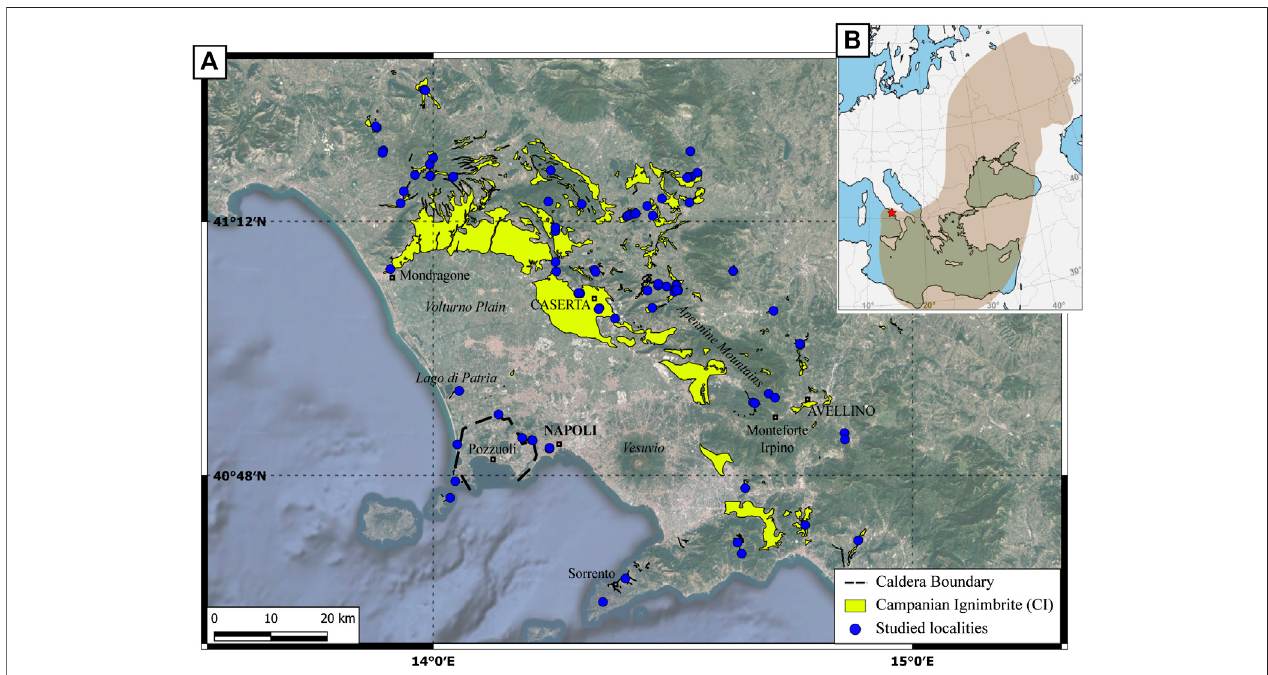
FIGURE1| The Campanian Ignimbrite distribution (A) .The Campanian Ignimbrite (CI) distribution intheCampanian region (thebasemap isfromGoogleSatellite), de fi nedmerging fi eldworkand geological maps(ServizioGeologicod ’ Italia,1963;ServizioGeologicod ’ Italia,1966;ServizioGeologicod ’ Italia,1967;Servizio Geologico d ’ Italia, 1971a; Servizio Geologico d ’ Italia, 1971b; Servizio Geologico d ’ Italia, 1975; ISPRA, 2009; ISPRA, 2010; ISPRA, 2011a; ISPRA, 2011b; ISPRA, 2011c; ISPRA, 2011d; ISPRA, 2014a; ISPRA, 2014b; ISPRA, 2016; ISPRA, 2018). Blue dots indicate the location of the studied exposures (coordinates are reported in the Supplementary Material ). (B) Dispersal area of the CI tephra from the Campi Flegrei caldera (red star), modi fi ed from Giaccio et al. (2017). The maps were generated using the QGIS Open-Source 3.4